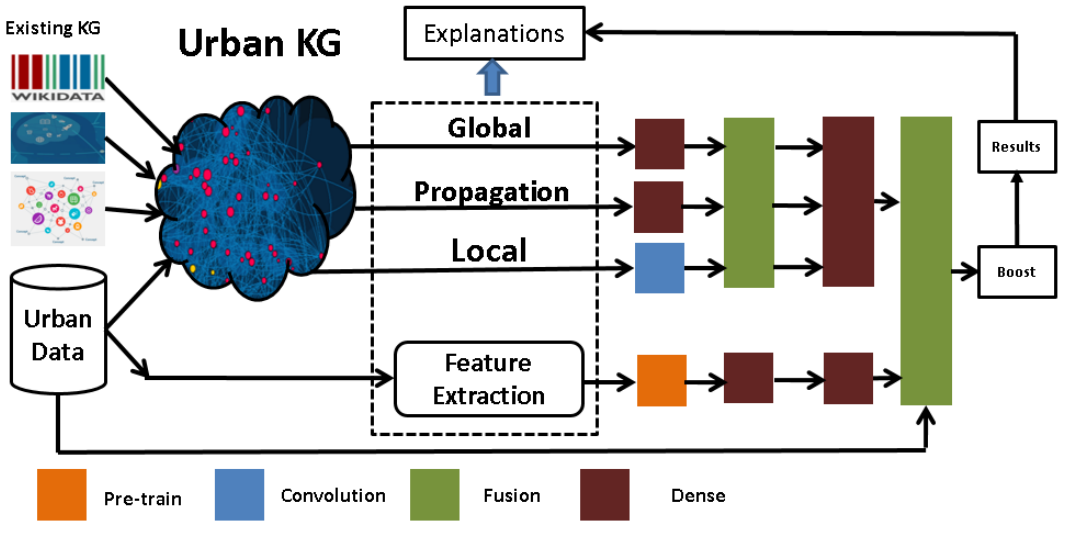
Figure 2. Proposed